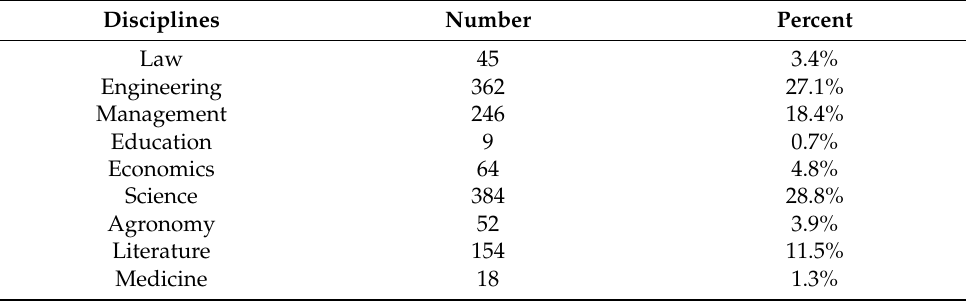
Table 1. Number of samples from nine